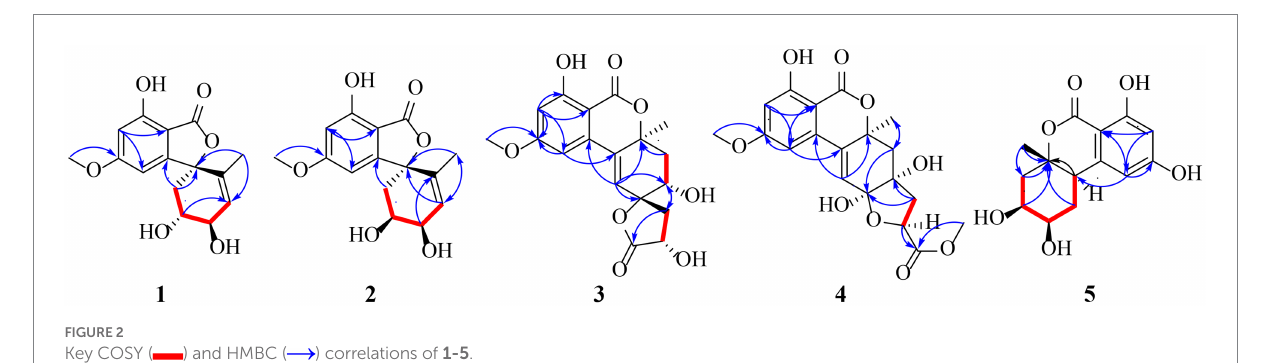
FIGURE 2 Key COSY ( ) and HMBC ( ) correlations of 1-5